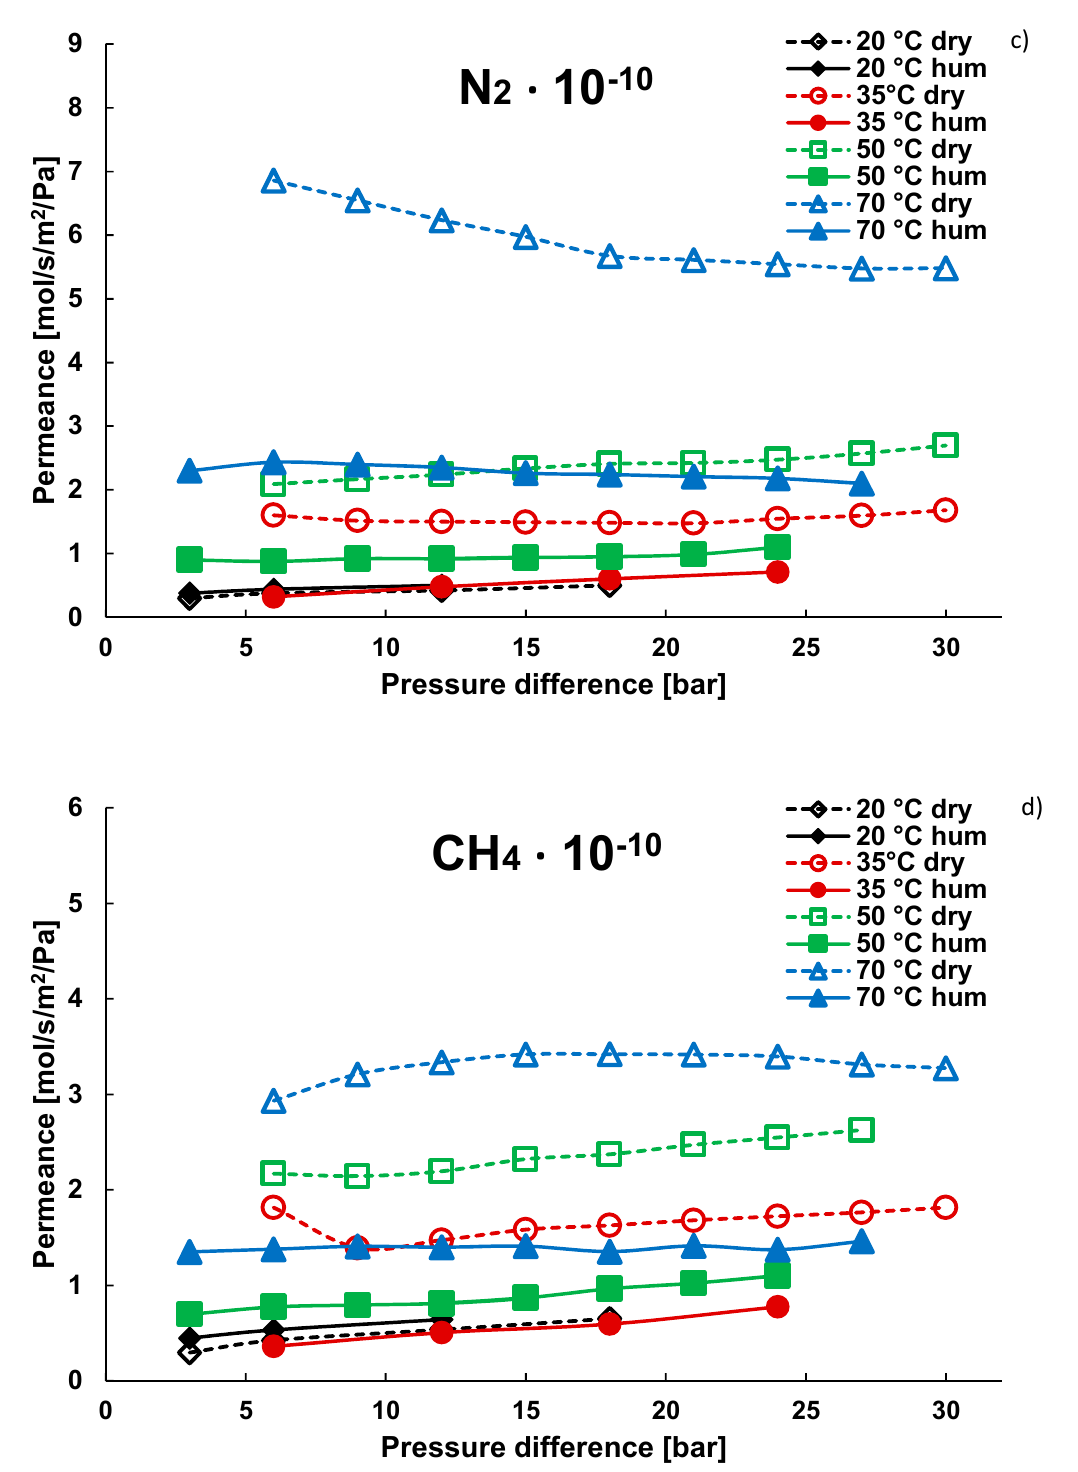
Figure 7. ( a ) H 2 , ( b ) CO 2, ( c ) N 2 , ( d ) CH 4 permeance with the humidified gas at several pressures and temperatures.